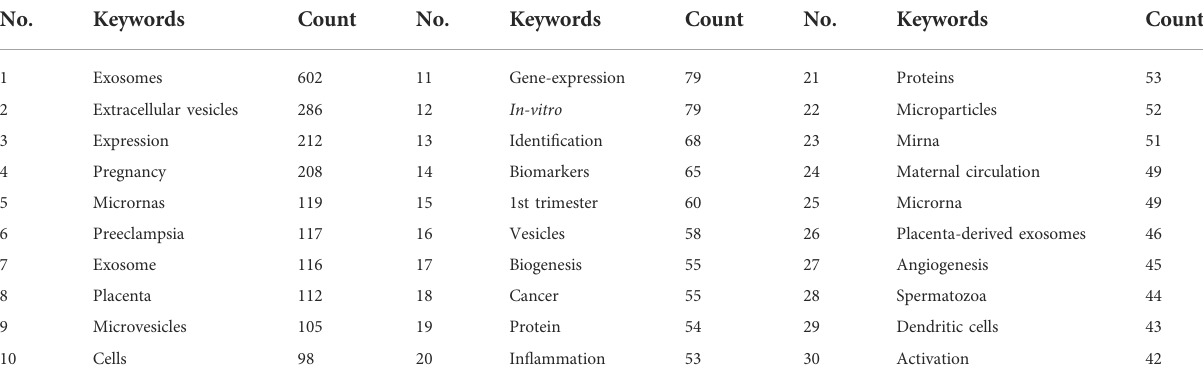
TABLE 6 Top 30 keywords of documents on exosomes in reproduction.